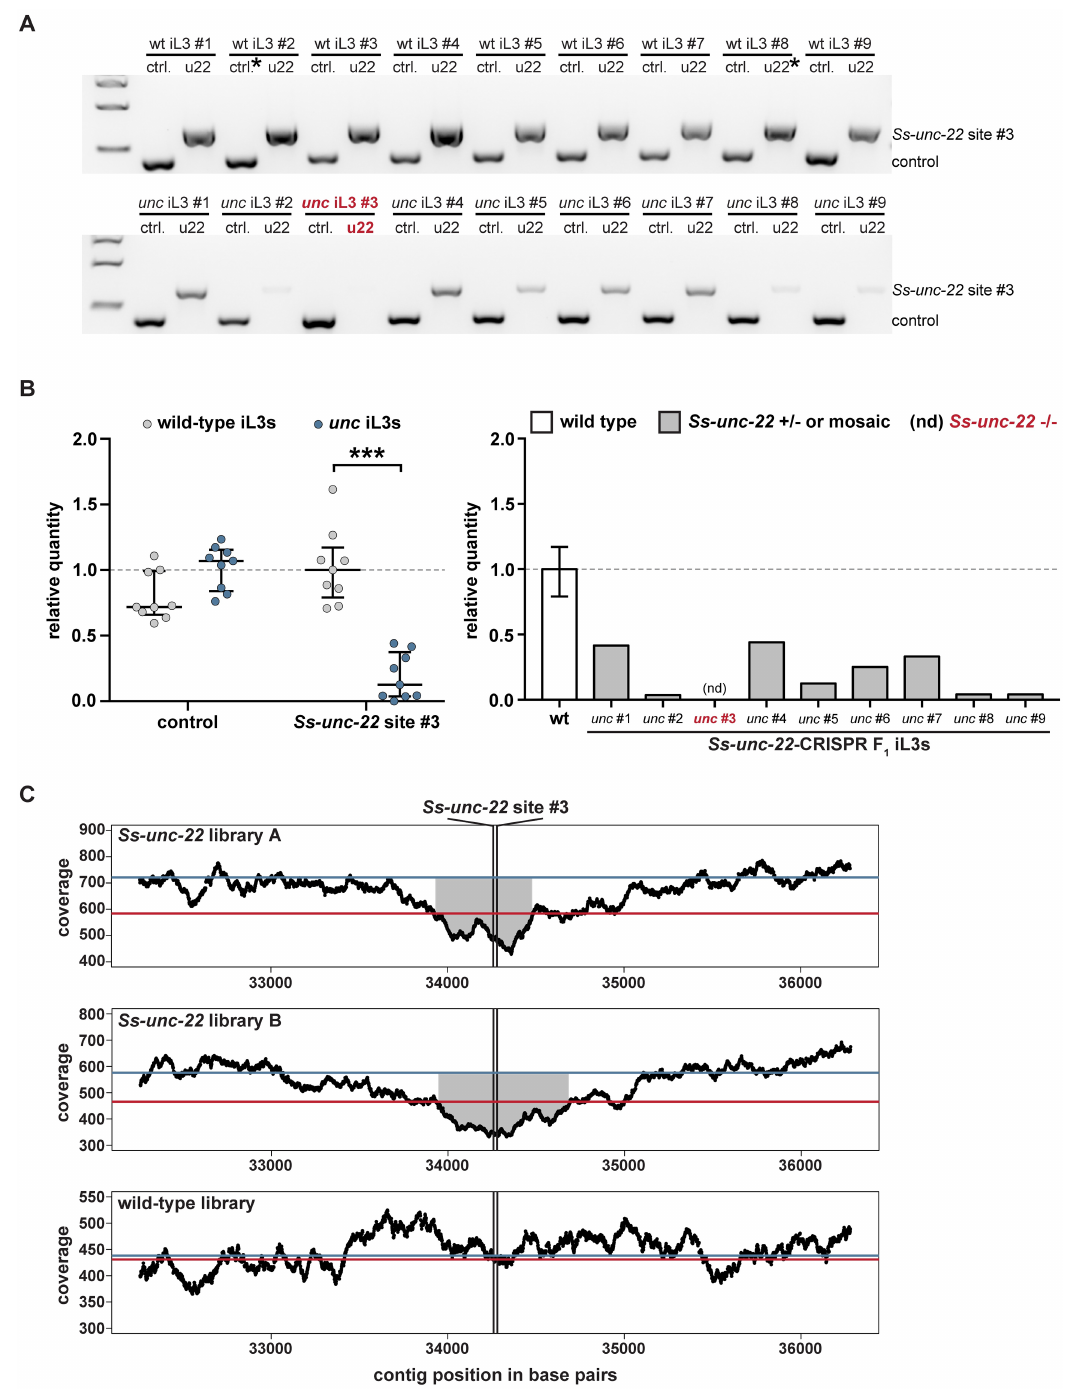
Fig 4. CRISPR-mediated mutagenesis of Ss-unc-22 results in putative deletion of the target locus. ( A ) Representative gel of wild-typeiL3s (top) or unc F 1 iL3s from RNP injections at site #3 (bottom). Genomic DNA from each iL3 was split into two reactions: ctrl. = control reactionamplifying416 bp of the first exon of the Ss-act-2 gene to confirm the presenceof genomicDNA; u22 = reaction amplifying660 bp aroundsite #3. Size markers = 1.5 kb, 1 kb, and 500 bp from top to bottom. ( B ) The Ss-unc-22 regionis significantly depletedin unc F 1 iL3s. Left: relative quantity analysisof PCR products. All control bandsand all u22 bands were quantifiedrelative to their respective reference bands, denotedby asterisks in A . Values > 1 indicatemore PCR product than the reference whilevalues < 1 indicateless product. *** P < 0.001, two-way ANOVA with Sidak’spost-test. Mediansand interquartile rangesshown. Right: relative quantity of